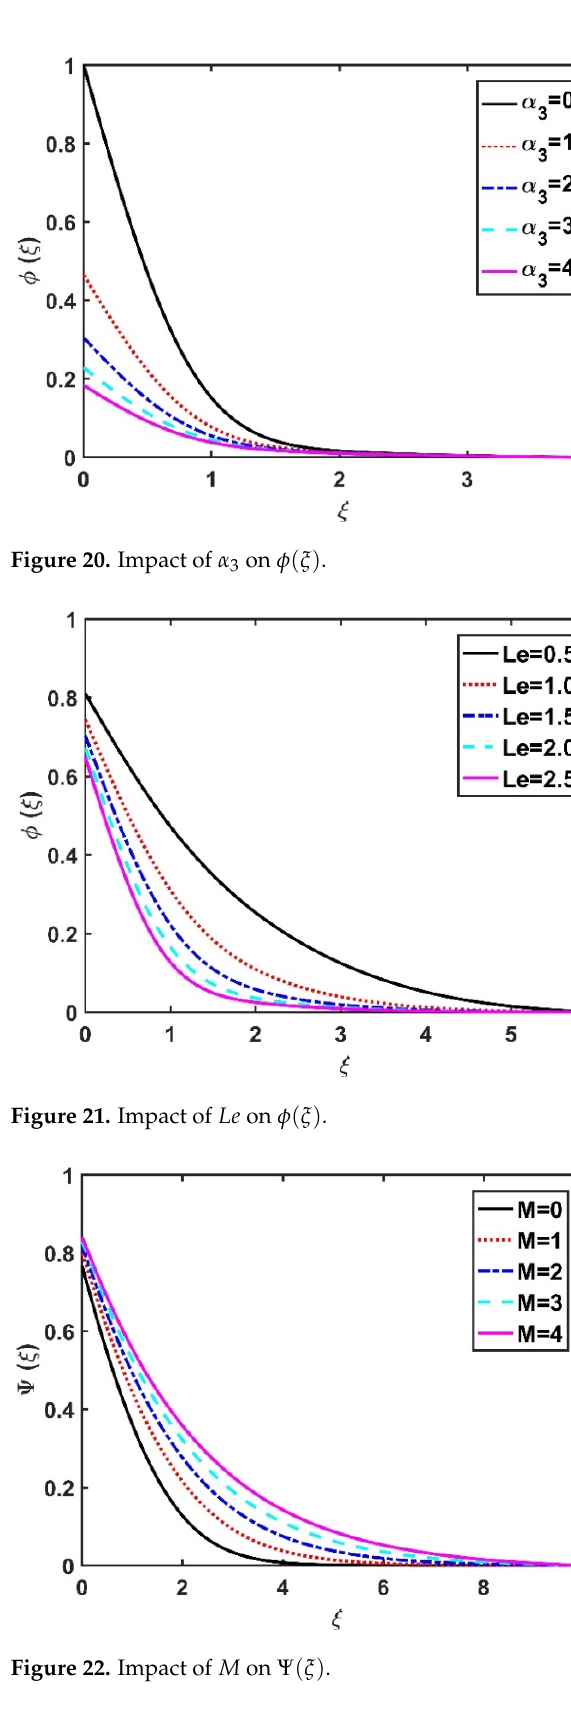
Figure 19. Impact of 𝑁𝑡 on 𝜙(cid:4666)𝜉(cid:4667) .